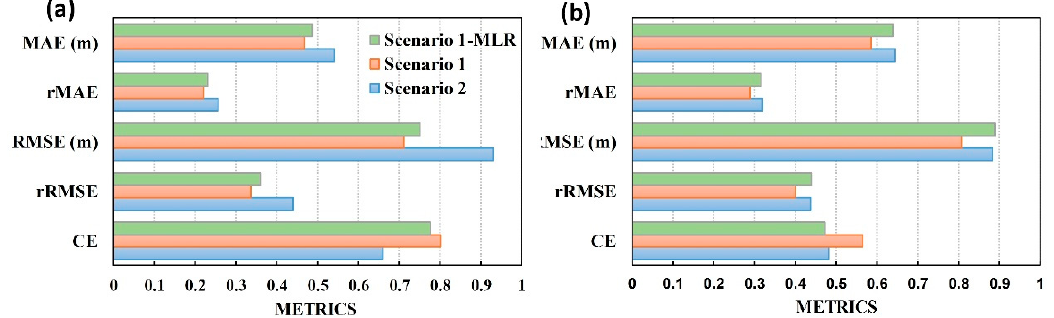
Figure 8. Performance levels of wave height predictions at a lead time of 1 h: ( a ) Longdong buoy and ( b ) Guishandao buoy.